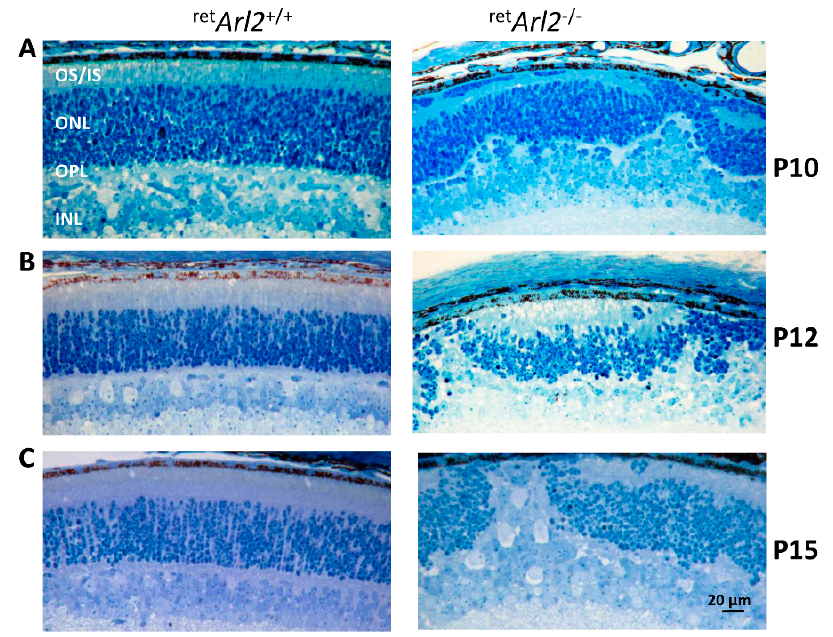
Figure 2. Histology of ret Arl2 − / − sections at P10–15. ( A – C ), plastic sections show histology of control (left panels) and ret Arl2 − / − retina (right panels) at days P10, P12 and P15. Note significant ONL/INL distortions, absence of OSs, abnormal ISs and displaced INL neurons in the P15 KO retina, reminiscent of retinas from Dync1h1 knockouts.